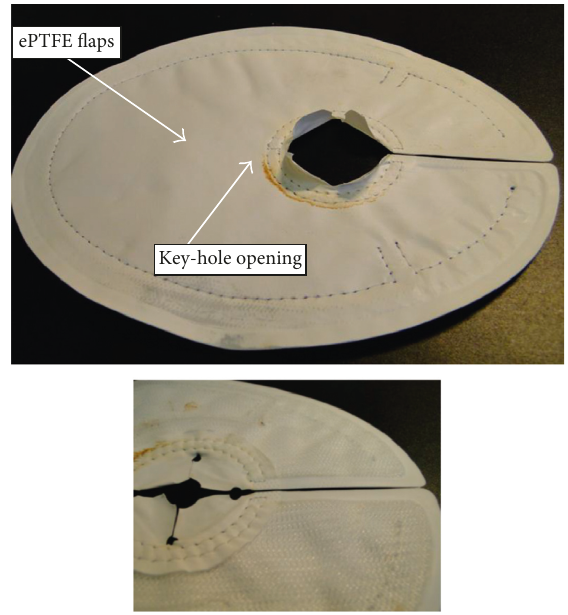
Figure 1: Picture of the Parastomal Hernia Patch